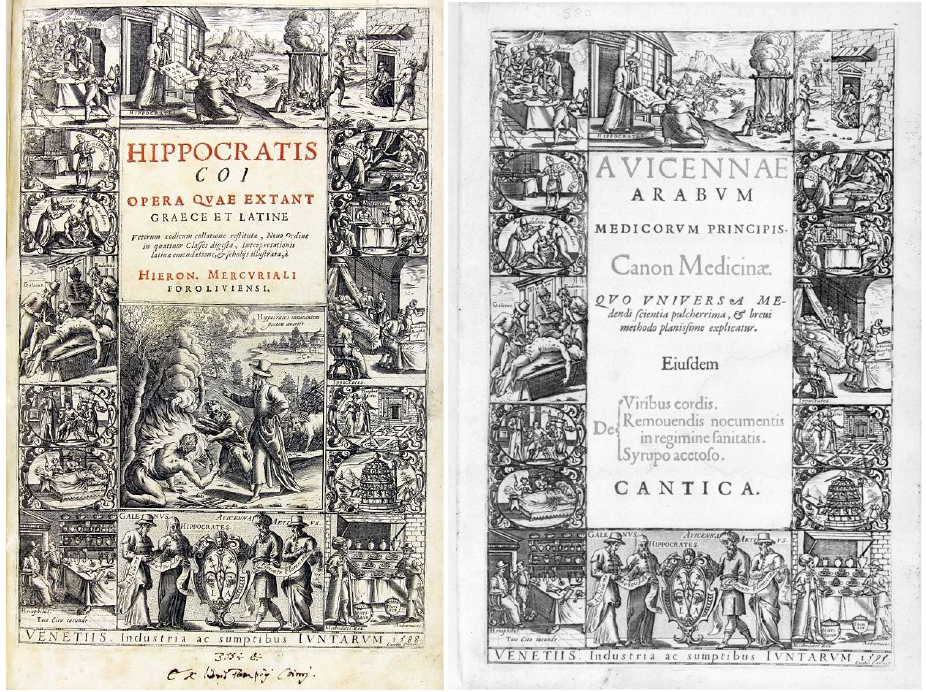
Figure 4. Frontispieces of Hippocrates’ [14] and Avicenna’s [15] works, published by Giunti.